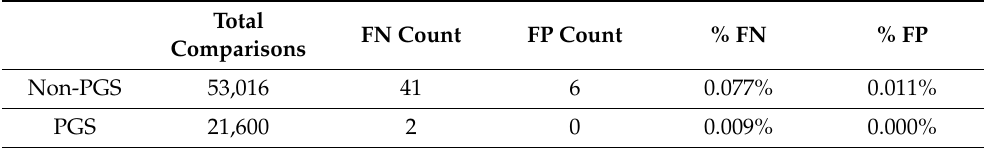
Table 3. Summary statistics for the false positive (FP) and false negatives (FN). The total comparisons were calculated by multiplying the number of participants by the number of comparisons per test